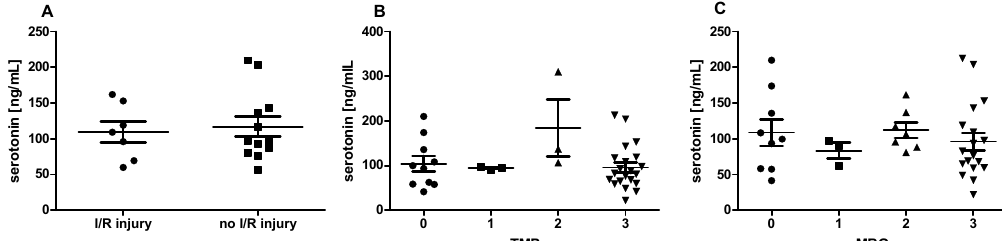
Figure 3. Serum serotonin and ischemia/reperfusion I/R injury. Serum serotonin levels did not differ between patients who suffered from I/R injury and those who did not. I/R injury was either assessed by ECG analysis ( A ) or by visual analysis of coronary angiography using the TIMI myocardial perfusion grade (TMP) ( B ) and the myocardial blush grade (MGB) ( C ).